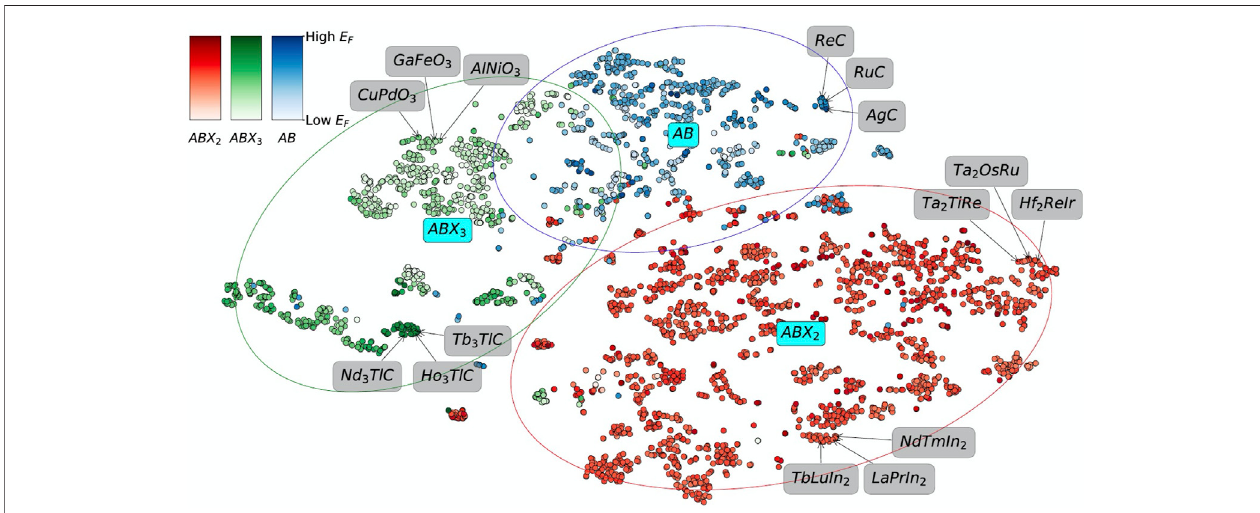
FIGURE 8 | Latent space for CVAE generated materials where colors represent the formation energy per atom of each structure (high intensity indicates high formation energy and low intensity indicates low formation energy). Reprinted with permission from Cole et al. (Court et al., 2020).